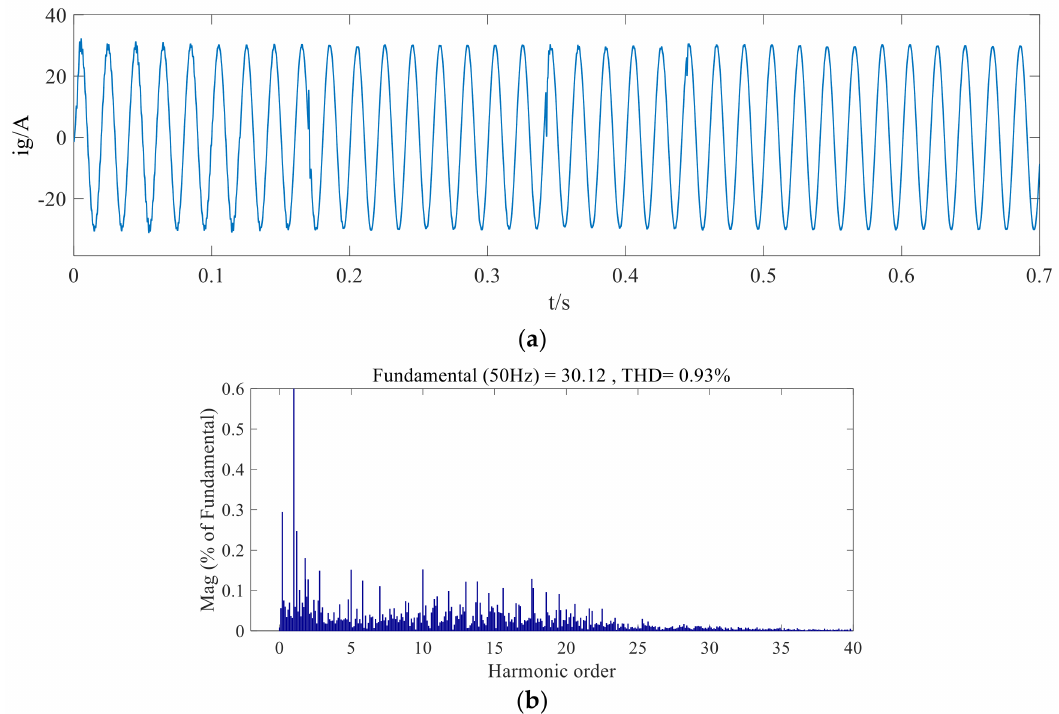
Figure 16. ( a ) Grid-connected current waveform after TSRC resonance suppression; ( b ) Grid-connected current harmonic analysis.